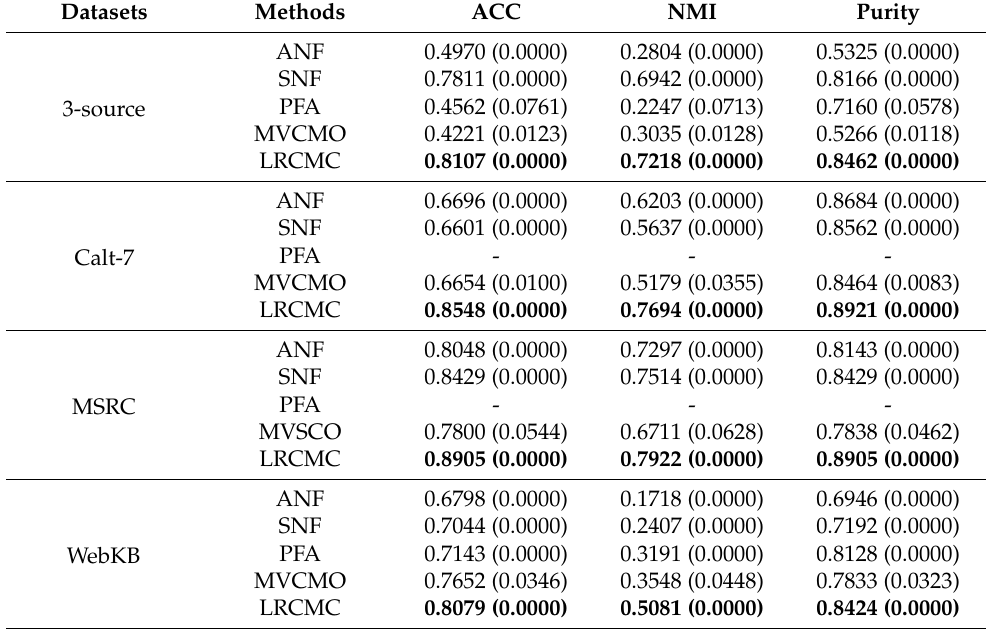
Table 2. The clustering performance comparison in terms of ACC, NMI and Purity on the four real datasets.